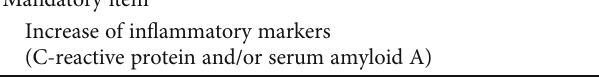
Table 2: Diagnostic criteria for patients with suspected cryopyrin- associated periodic syndrome (CAPS); adapted from Kuemmerle- Deschner et al.